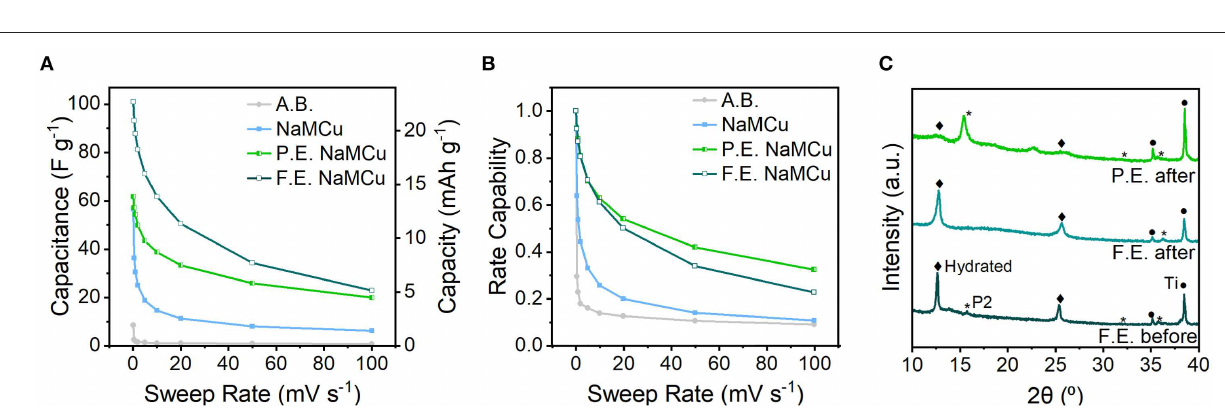
FIGURE 5 | Electrochemical energy storage rate capability and post-electrochemical cycling material structure. (A) Cathodic capacitance and (B) rate capability (cathodic capacitance normalized to the capacitance at 0.1 mV/s), from 0.1 to 100 mV/s. The low capacity and rate capability of the acetylene black (A.B.) conductive additive shows that the capacitive electrochemical response is due to the oxide active materials. (C) Ex situ XRD of electrodes after electrochemical cycling shows that the F.E. and P.E. retain their initial